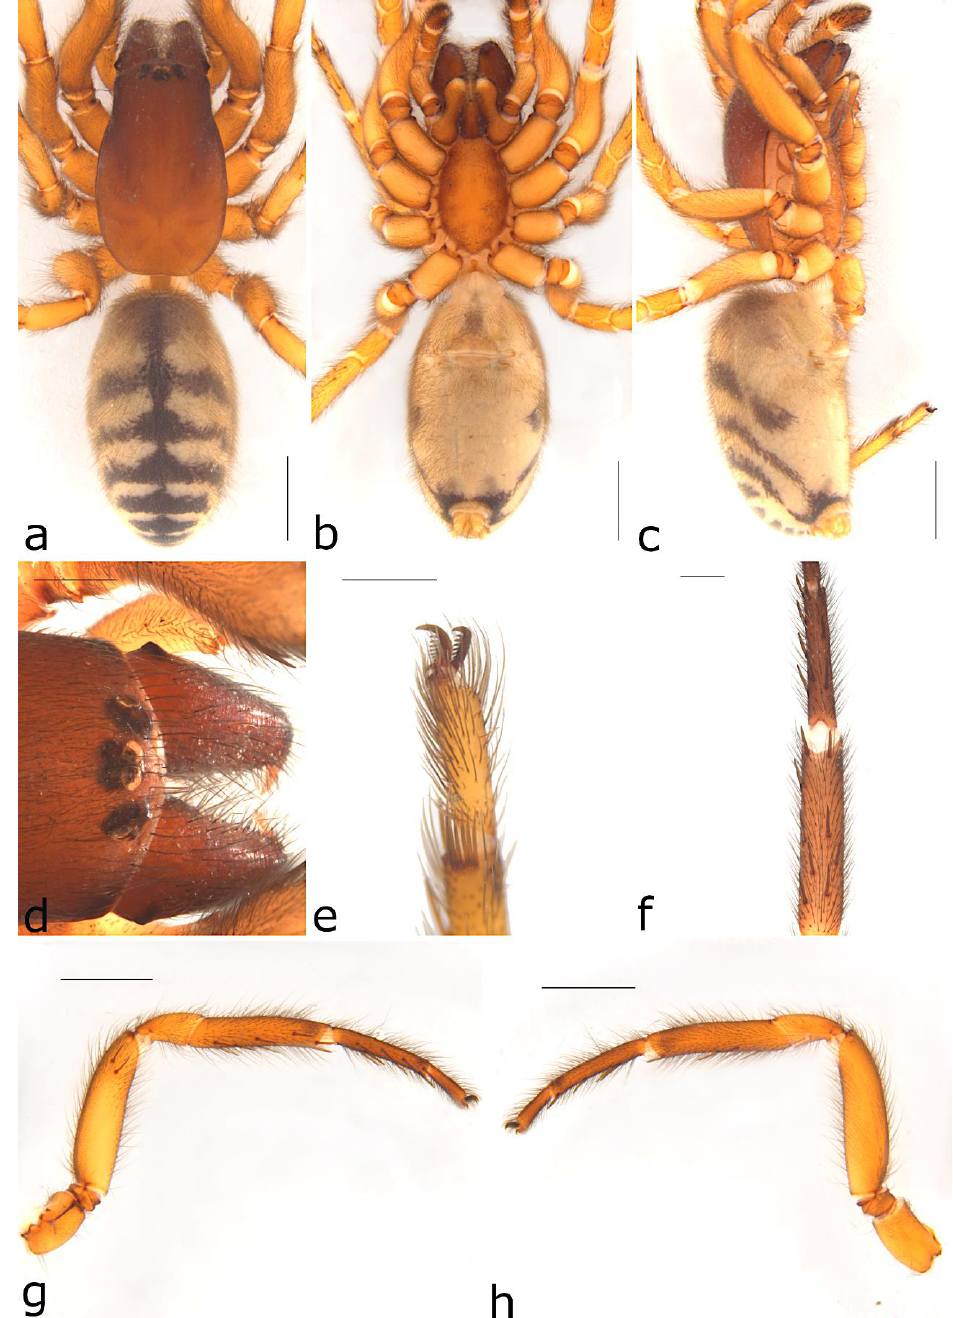
Figure 6. Ariadna clavata Marsh , Baehr, Glatz & Framenau, 2018 . ♀ paratype (SAMA NN29862) from Kangaroo Island (SA): ( a ) habitus, dorsal view; ( b ) same, ventral view; ( c ) same, lateral view; ( d ) eyes, dorsal view; ( e ) left metatarsus IV, preening comb, retrolateral view; ( f ) left leg I, ventral view; ( g ) same, prolateral view; ( h ) same, retrolateral view. Scale bars ( a – c ) = 1 mm, ( d ) = 0.5 mm, ( e ) = 1 mm, ( f ) = 0.5 mm and ( g , h ) = 1 mm.